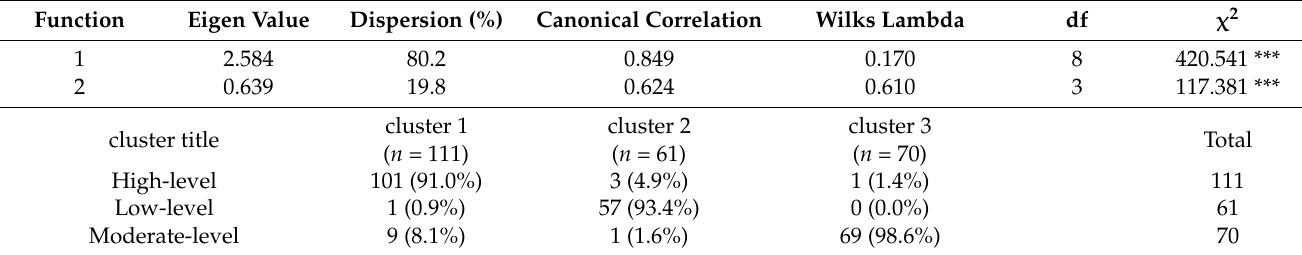
Table 6. Results of Discriminant analysis for